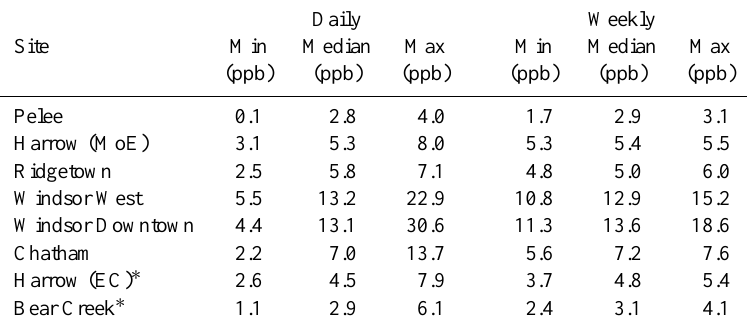
Table 2. Minimum, median and maximum observed 1-day and 1-week average NO 2 concentrations measured by chemiluminescence monitors during the BAQS-met campaign. All monitors not marked with a ∗ were heated molybdenum converted chemiluminescence monitors while those marked with a ∗ were photolytically converted chemiluminescence